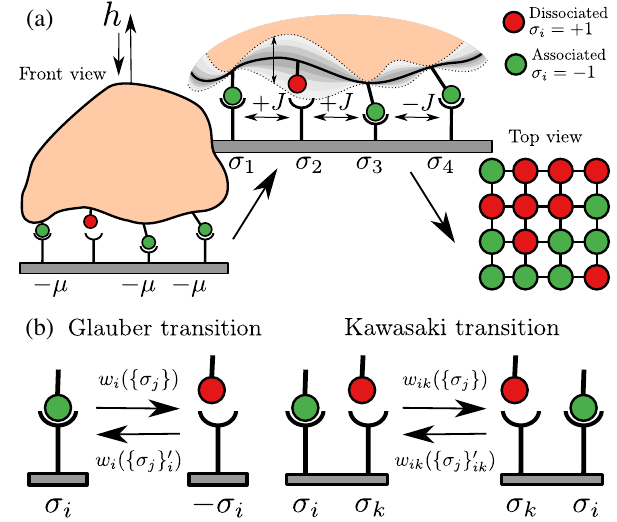
FIG. 1. Coarse-grained model for the cooperative association or dissociation of adhesion bonds. (a) Schematic of the effective many-body model governed by Eqs. (1) and (2), depicting an adhesion domain on a cell patch with 16 CAMs anchored to a stiff substrate. Adhesion bonds are arranged on a 4 × 4 square lattice 1 , where þ 1 corresponds to an and can assume two states, σ i ¼ (cid:2) open (red) and − 1 to a closed bond (green). Nearest-neighbor bonds experience an effective interaction J induced by undu- lations of the anchoring membrane. An external force h is pulling or pushing on the adhesion domain. Each adhesion bond has an intrinsic binding affinity μ ≥ 0 that favors a bound state. A small number of bonds is depicted for convenience only. In this work, we consider different system sizes, including the thermodynamic limit. (b) Glauber and Kawasaki transition. A Glauber transition → − σ changes the binding state of a single adhesion bond to σ i i σ with transition rate w [see Eq. (3)]. A Kawasaki transition i ðf j gÞ ↔ σ interchanges two nearest-neighbor adhesion bonds σ with i k σ transition rate w [see Eq. (5)], corresponding to lateral ik ðf j gÞ